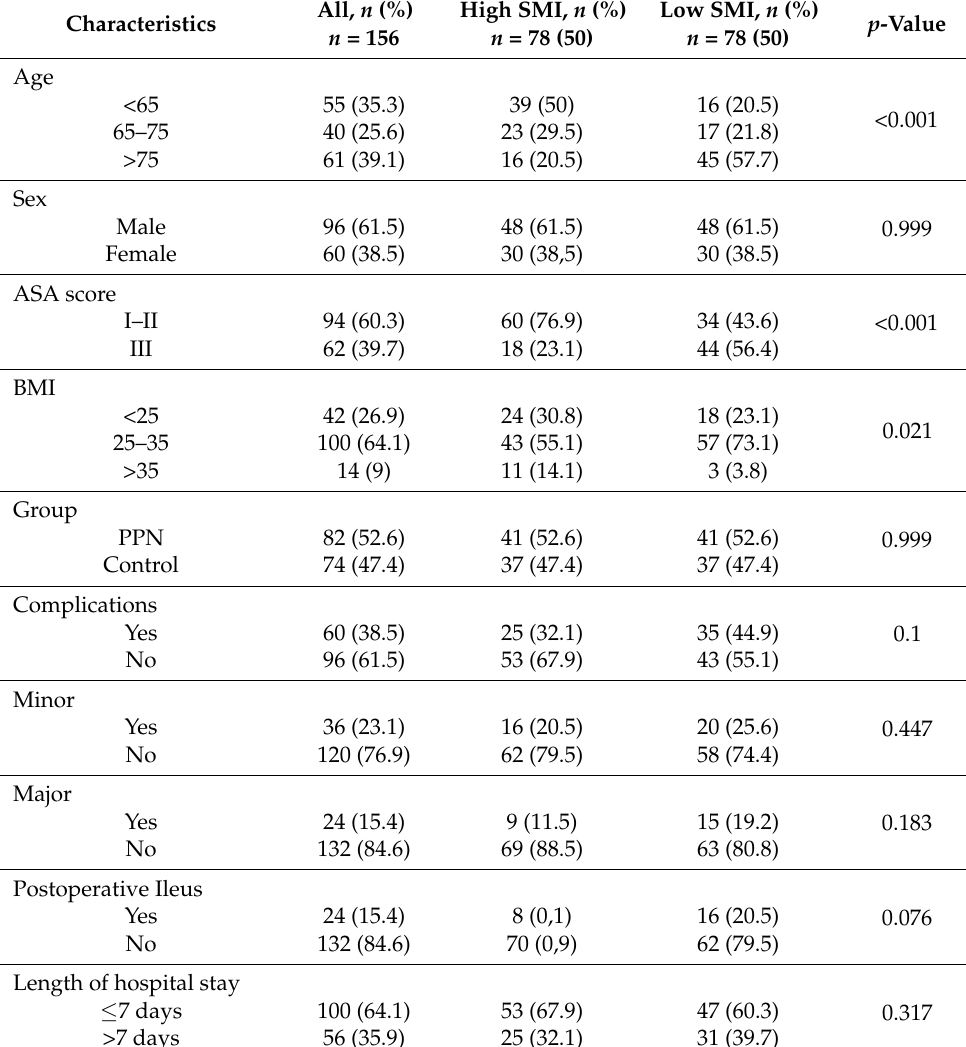
Table 1. The relationship between the clinicopathological characteristics and the clinical outcomes stratified by